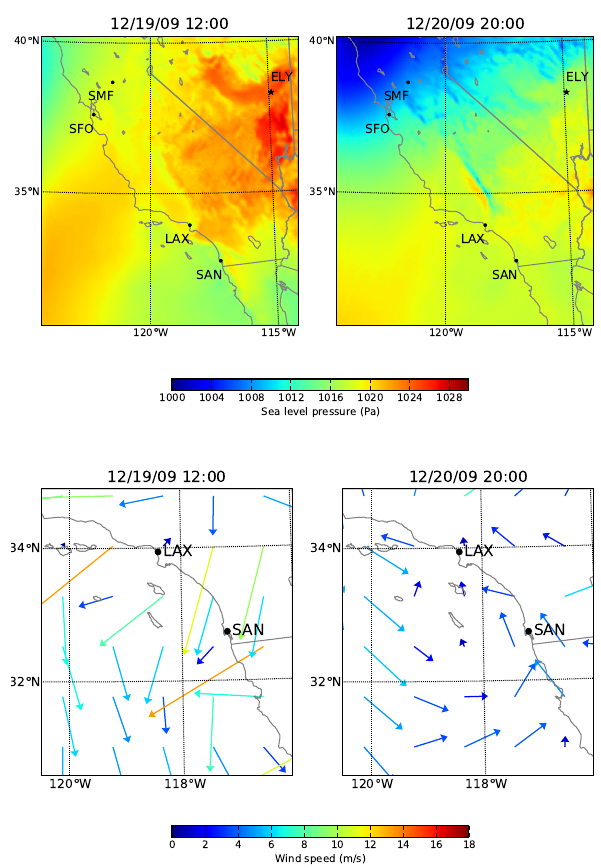
Fig. 9. Sea-level pressure maps above California for 19 and 20 De- cember 2009 at noon (local time) for the P4E12c simulation. Wind Fig.9. Sea-levelpressuremapsaboveCaliforniaforDecember19 th , 2009andDecember20 th , 2009atnoon 33 pattern above Los Angeles and San Diego; the direction is indicated (local time) for the P4E12c simulation. Wind pattern above Los Angeles and San Diego; the direction is through arrows while the speed is plotted in a color indicatedthrougharrowswhilethespeedisplottedinacolorscale.